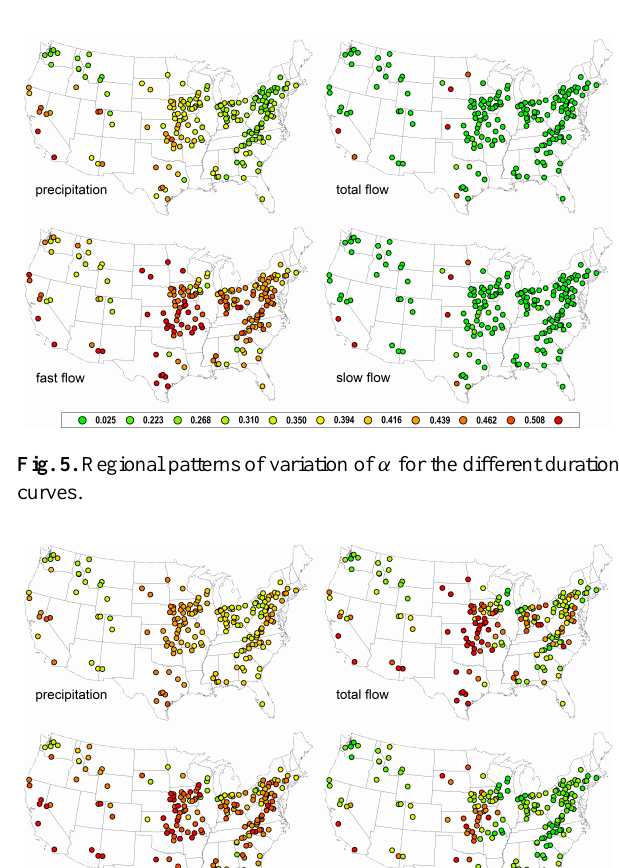
Fig. 4. Values of R 2 and Ens of the mixed gamma distribution fitting to (a) normalized duration curves of 197 catchments and (b) 54 annual duration curves of 8 catchments. The plus signs ( + ) are the mean of all the fitted duration curves; the upper and lower whiskers represent the maximum and minimum values; the upper and lower lines of the box represent the third and first quartiles, and the line within the box indicates the median value.